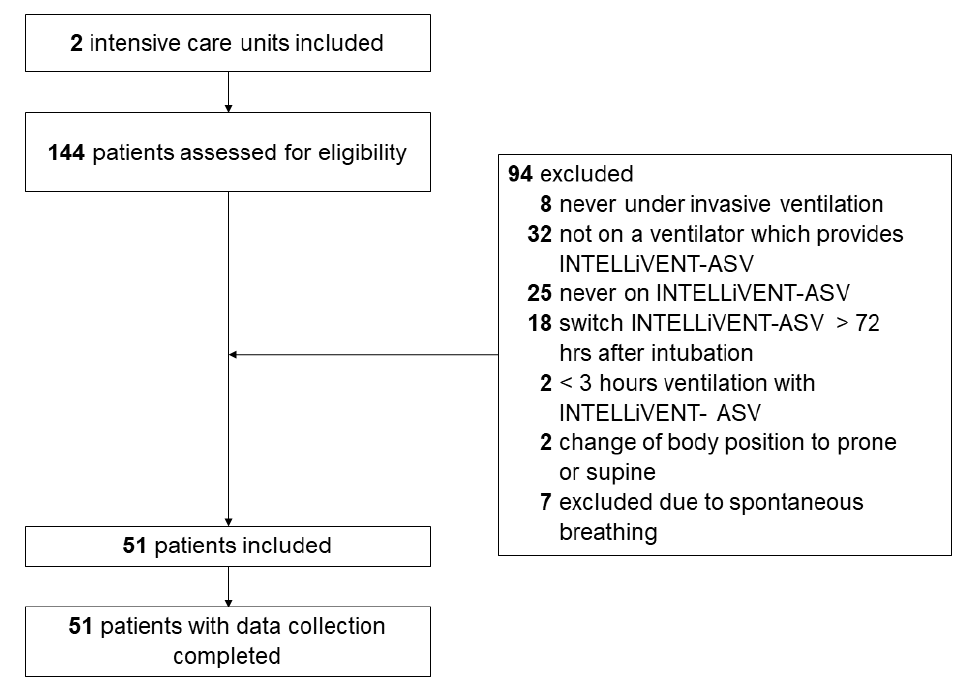
Figure 1. Study profile. Consort diagram showing flow of patients. Demographic data, including preceding medication, the severity of disease and co- morbidities, are presented in Table 2. The majority of patients were male, and the median age was 63 (IQR 51 to 69) years. Of all included patients, 14% met the current definition for mild ARDS, and 55% and 31% met the definition for moderate or severe ARDS, respec- tively. Patients were under invasive ventilation for a median of 10 h (IQR 3 to 48) before ventilation was converted from conventional ventilation to